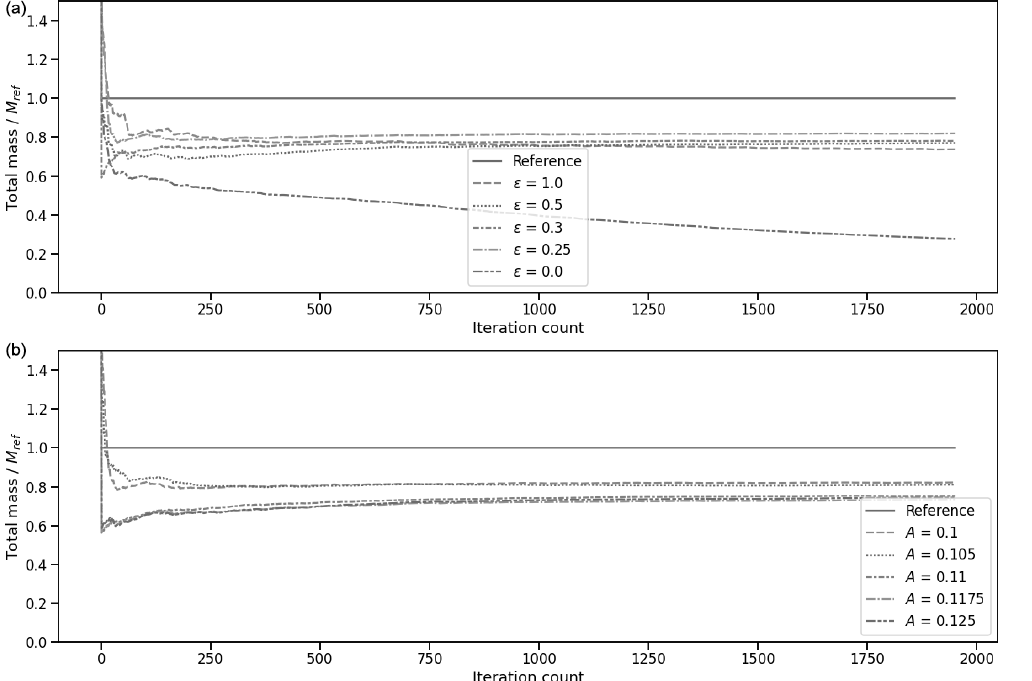
Figure 7. Evolution of the total plastic mass in the forecast simulation for five different runs with varying values of double-gyre parameters A and (cid:15) , along with the total plastic mass in the reference